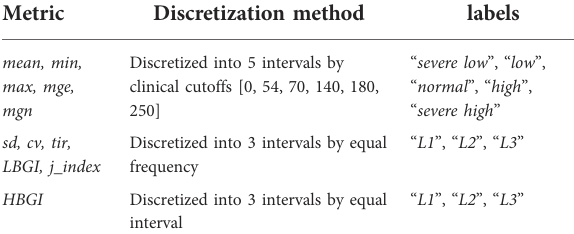
TABLE 1 Discretization of GV